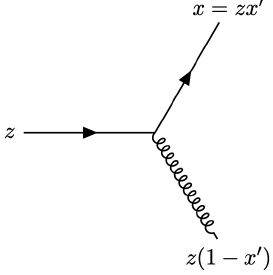
Figure 1 . Pictorical representation of the g → q ¯ q splitting and momentum fraction of the involved